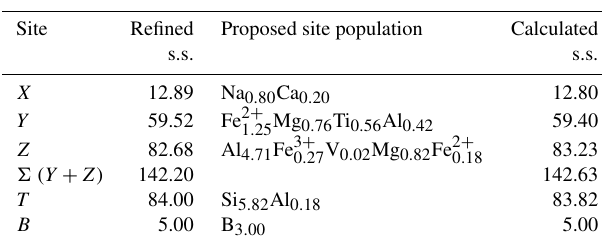
Table 7. Refined and calculated site-scattering (s.s., in electrons per formula unit) and proposed site population (in atoms per formula unit) for